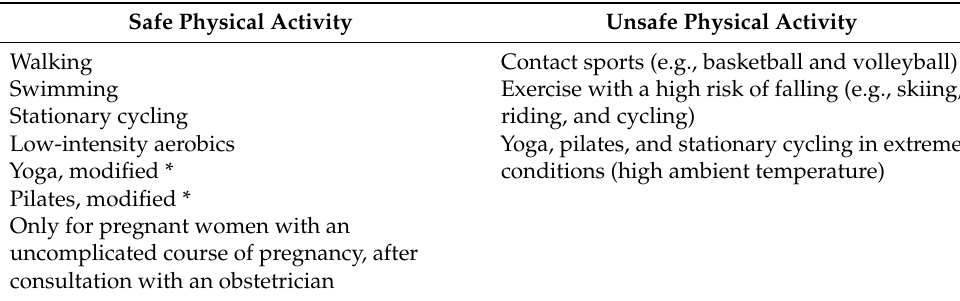
Table 4. Safe and unsafe exercise during pregnancy.